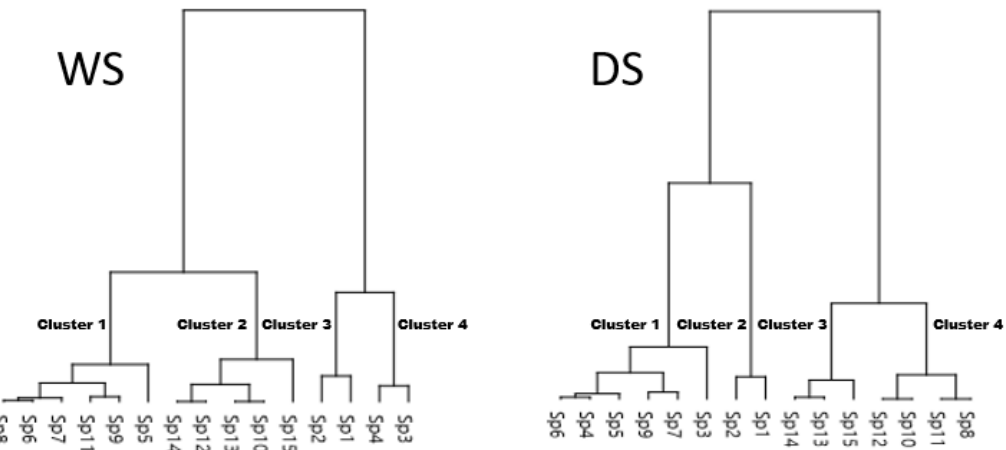
Fig. 3. Dendrogram (using Ward Method) showing spatial similarities of monitoring sample points produced by cluster analysis